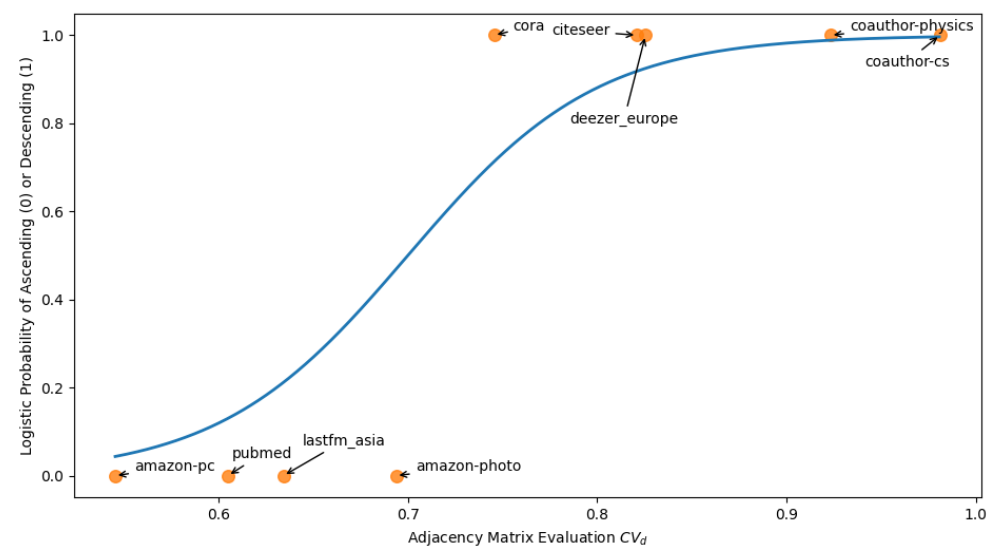
Figure 7. Logistic probability (blue line) shows an increasing likelihood of a descending sampling procedure as the coefficient of variance of the degree ( CV d ) increases. Results show that a complete separation is defined by CV d